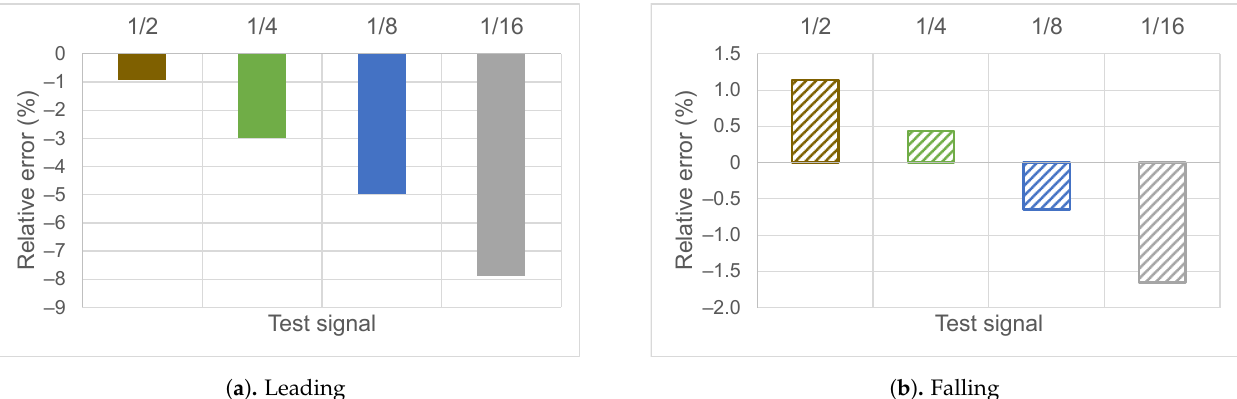
Figure 13. Fundamental active energy relative error: ( a ) leading; and ( b )